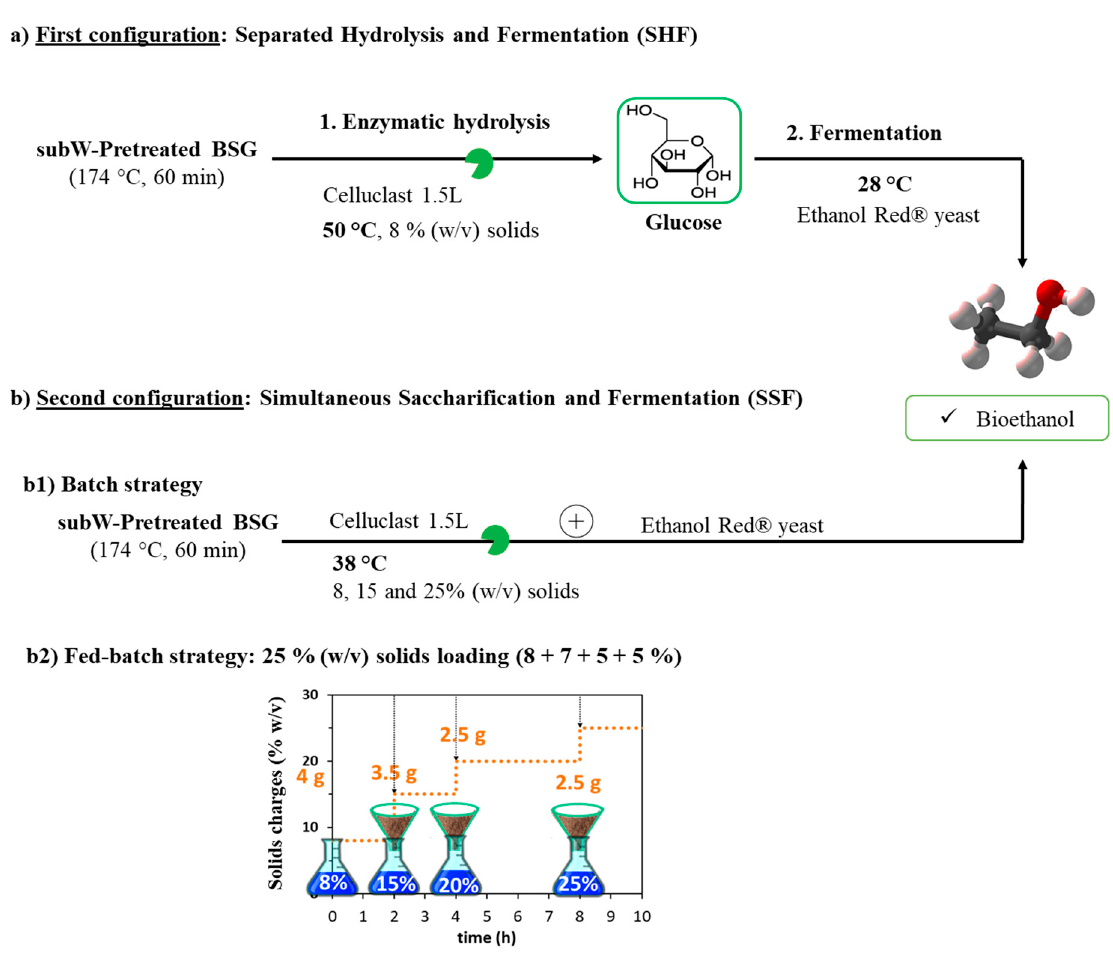
Figure 1. Hydrolysis and fermentation configurations employed in this work. ( a ) Separate hydrolysis and fermentation (SHF) at 8% ( w/v ) solids loading. ( b ) Simultaneous saccharification and fermentation (SSF) followed in ( b1 ) batch (8, 15, and 25% w/v solids loading) or in ( b2 ) fed-batch operation mode to reach a high solids’ loading of 25% ( w/v ).